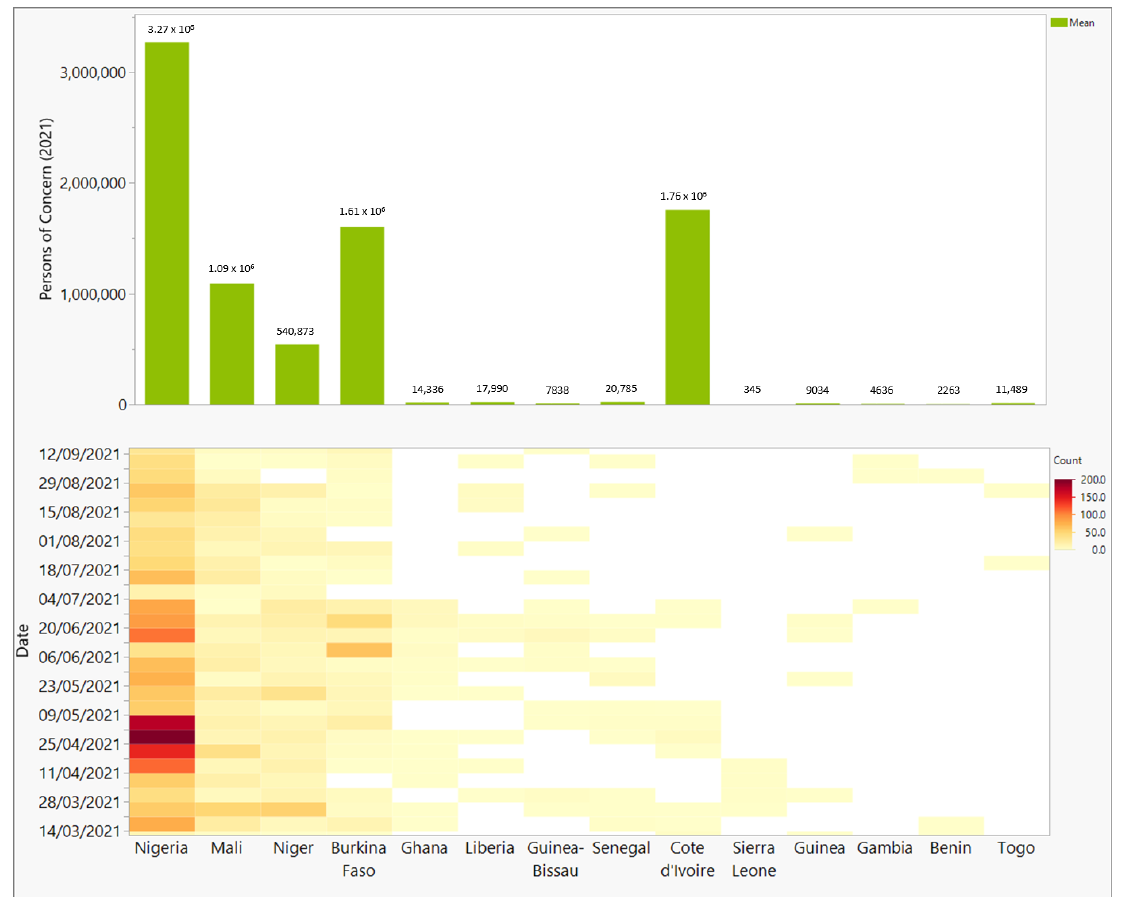
Figure 1. The media coverage given to each country over the 6 months considered in this study (bottom) in comparison with the total number of persons of concern in each country